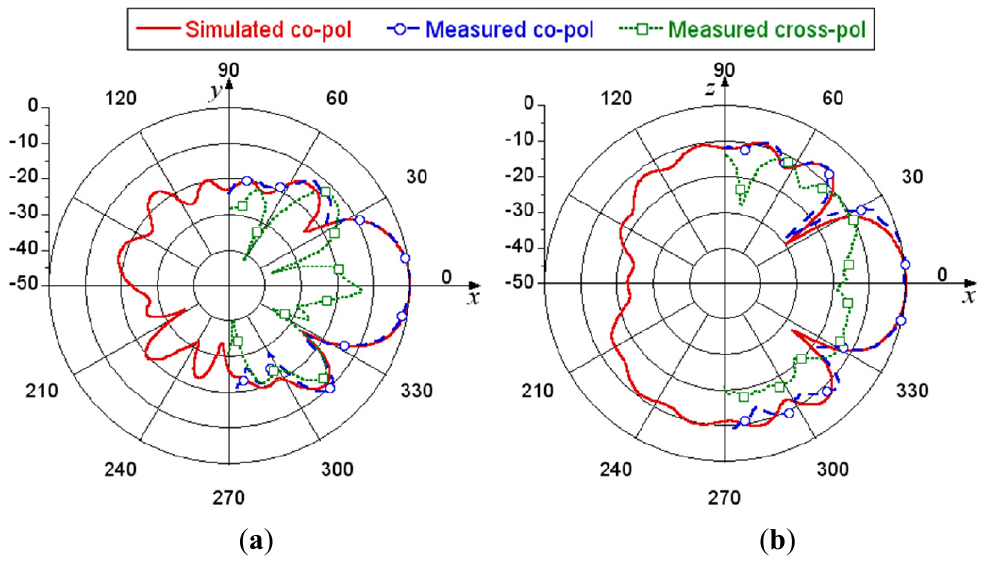
Figure 4. Measured and simulated radiation patterns in free space at 60 GHz: ( a ) E - and ( b ) H -planes.